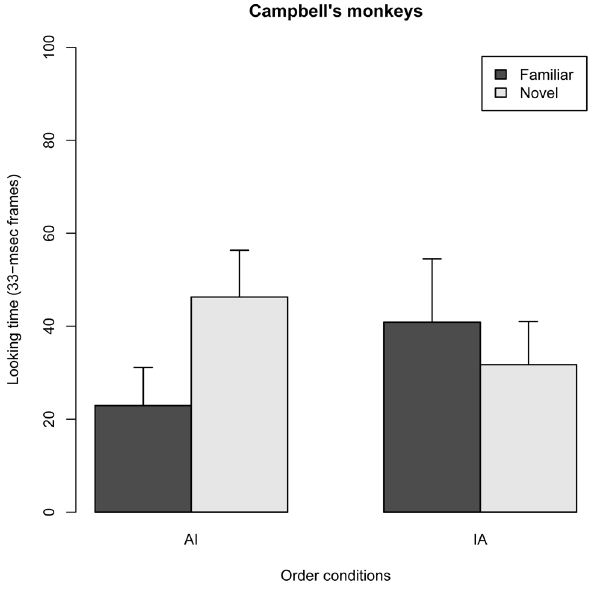
Figure 5. Looking times (LTs) for the novelty stimulus and order conditions in 10 Campbell ’ s monkeys. In the AI condition, the adult image was used as the stimulus in the familiar phase and the infant image was used as the novel stimulus in the test phase. In the IA condition, the infant image was used as the stimulus in the familiar phase and the adult image served as the novel stimulus in the test phase. Error bars represent mean values 6 95% confidence intervals. Black bars, familiar stimuli; white bars, novel stimuli.